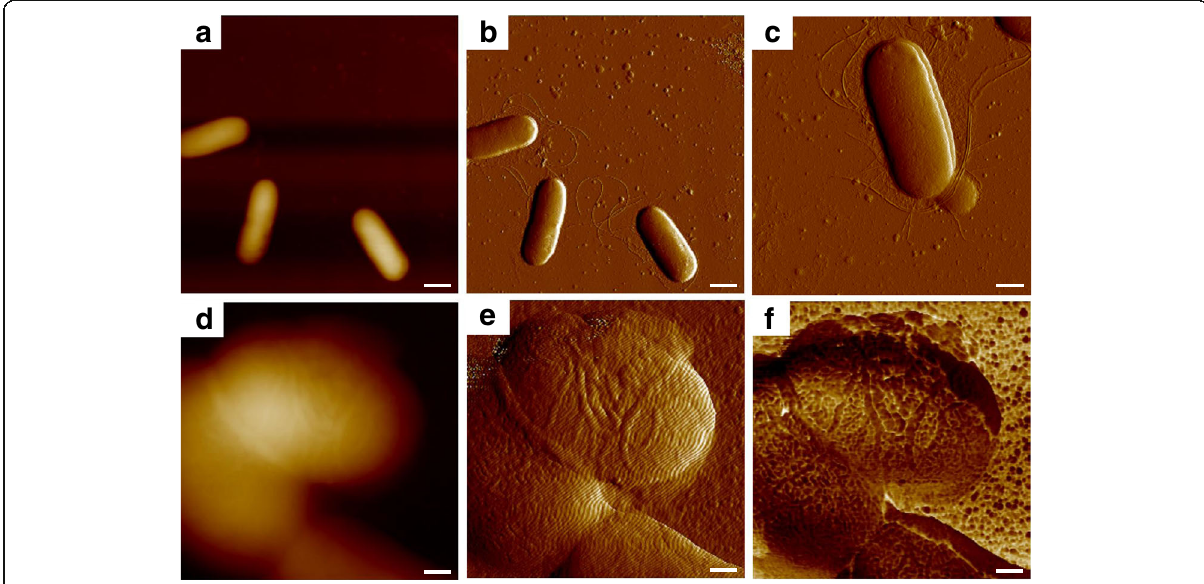
Fig. 1 Surface ultrastructure of E. coli MG1655 using AFM multiple mapping. a and b were the topographical and deflection error images, and c was the detailed deflection error image of the bacterial cell with the expression of flagella and pili. A single cell was then focused, where d and e were the topographical and deflection error images, and f was the corresponding adhesion mapping. The scale bars = 1 μ m in a and b , 500 nm in c , and 200 nm in d –